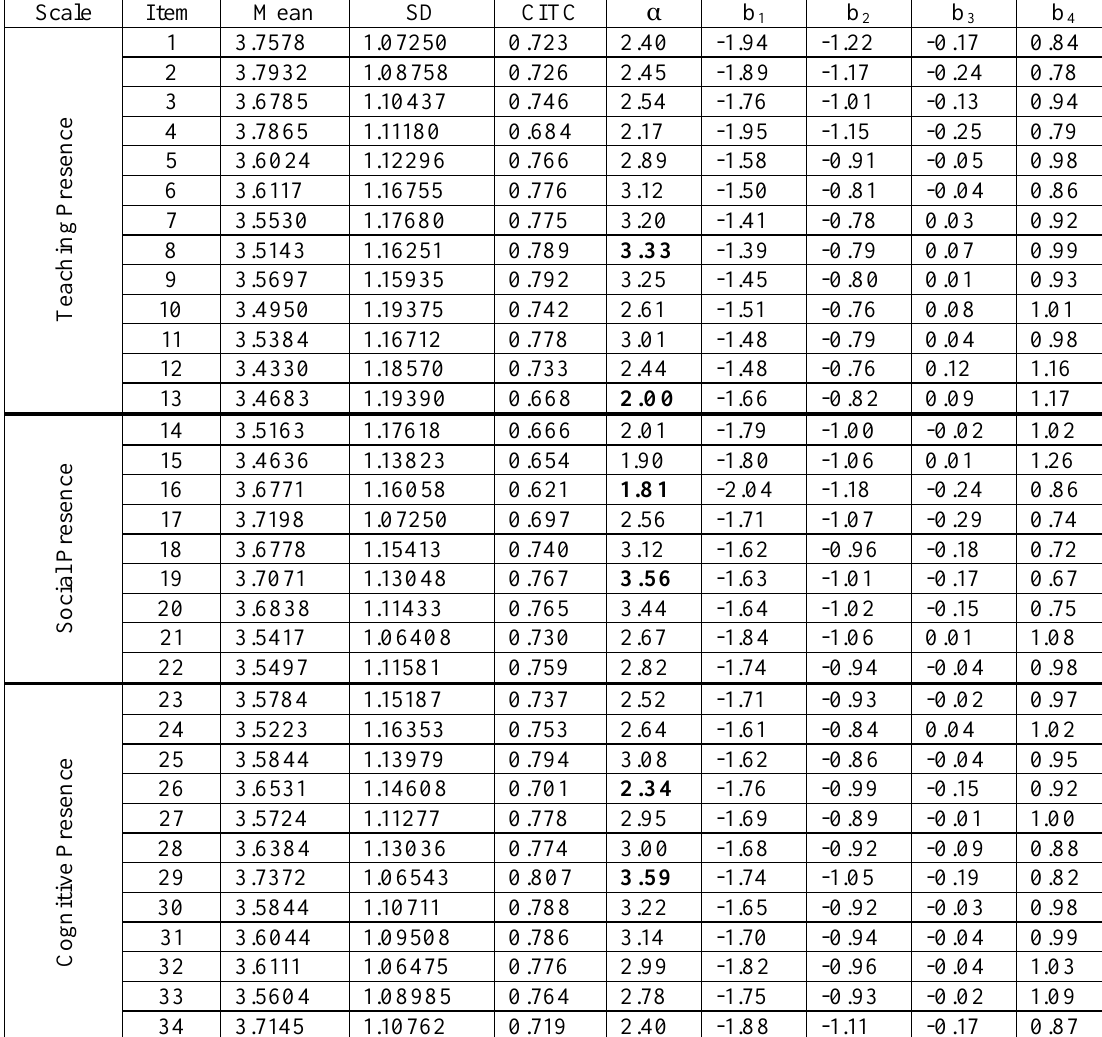
Table 2 Item Statistics and Item